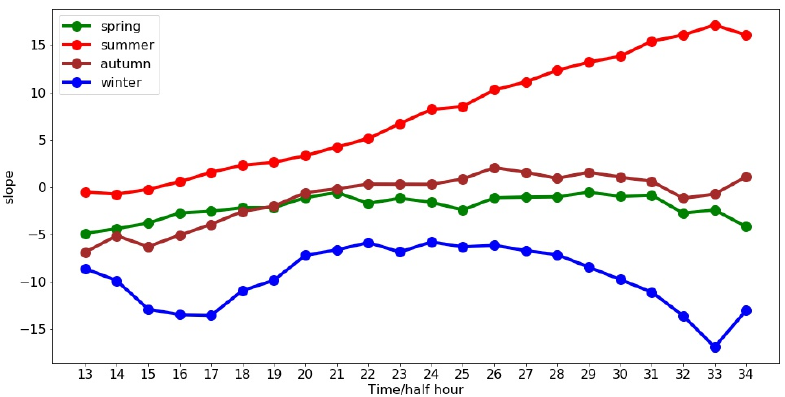
Figure 5. Slope of the linear fitting of delta temperature and approximate delta actual load.